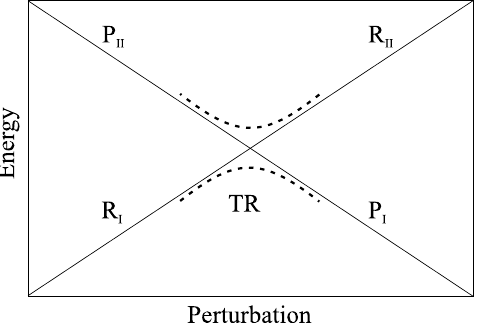
Figure 1. Schematic description of the diabatic ( solid lines ) and adiabatic ( dashed lines ) energy surfaces within the energy vs. perturbation